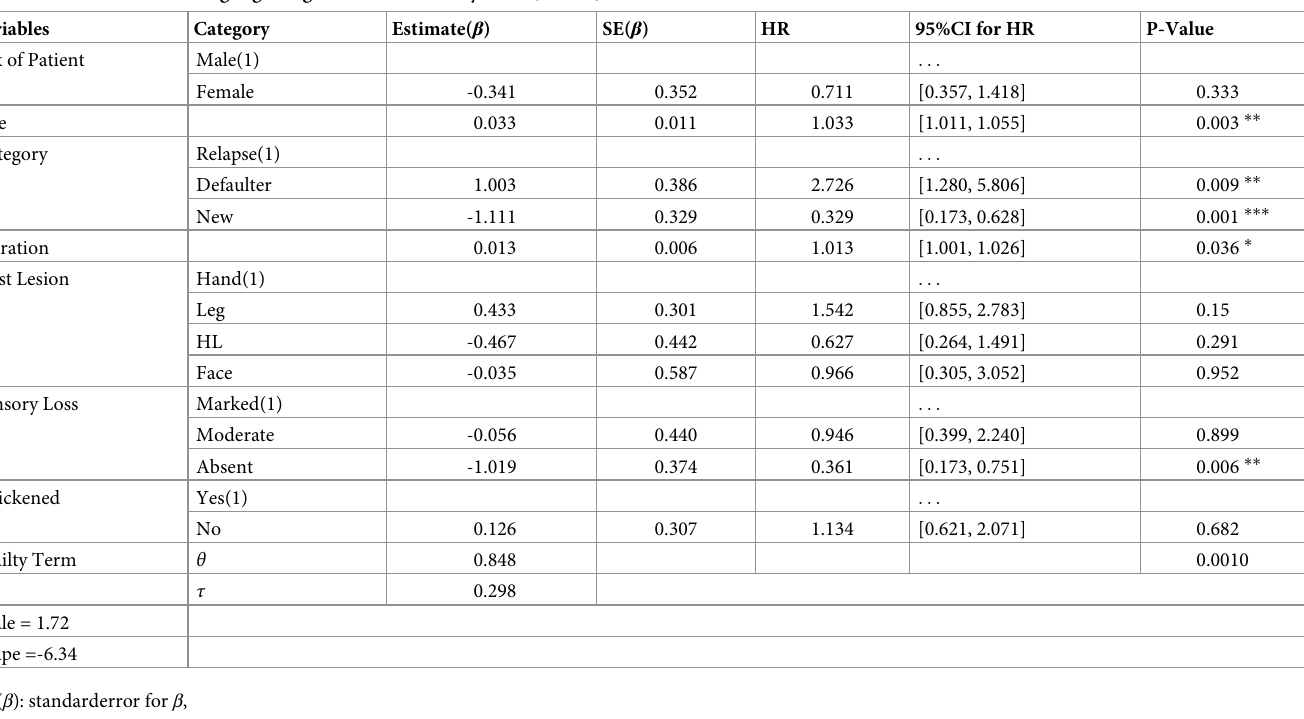
The Cox-Snell residuals had been obtained from fitting the Weibull and log logistic models to the data. The figures below display the diagnostic based on Cox-Snell residuals with the 95% point wise CI for the Kaplan-Meier estimate of the Cox-Snell residuals along the red line. Since the Weibull distribution becomes to be below the lower confidence interval at the end (Fig 4), but for log-logistic, the line is more in touch with the Kaplan-Meier estimate line and completely within the confidence intervals therefore the log-logistic distribution provides a good fit to the data (Fig 5). The Cox Snell residual plots. The Cox-Snell residuals (together with their cumulative hazard function) had been obtained by fitting the Weibull and the log-logistic models to the Table 8. Results of the final log-logistic-gamma shared frailty model, LPAC, 2015–2019.